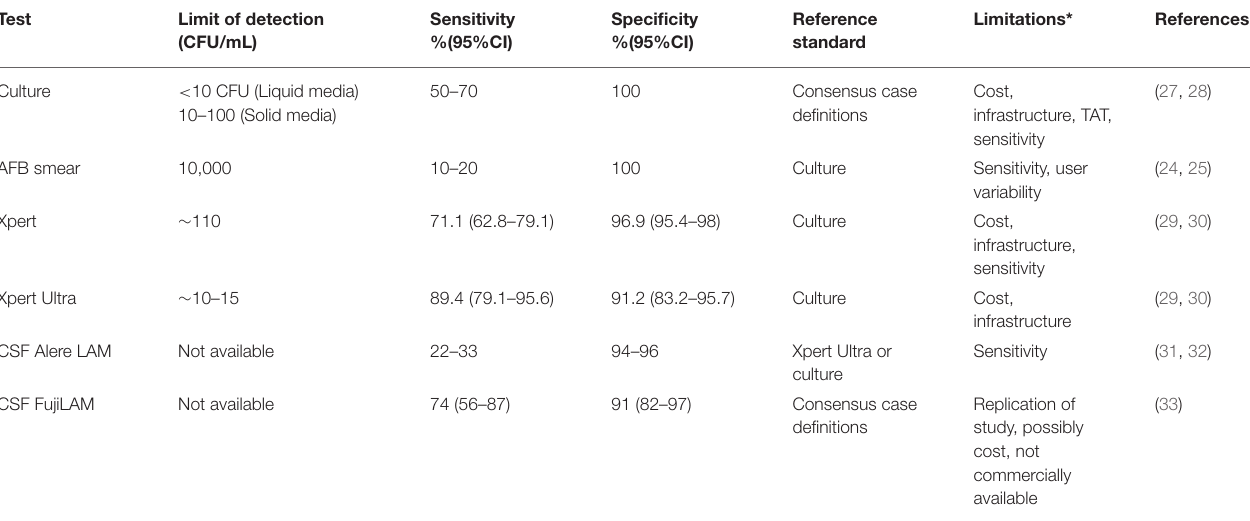
TABLE 2 | Diagnostic performance for selected tests for tuberculous meningitis